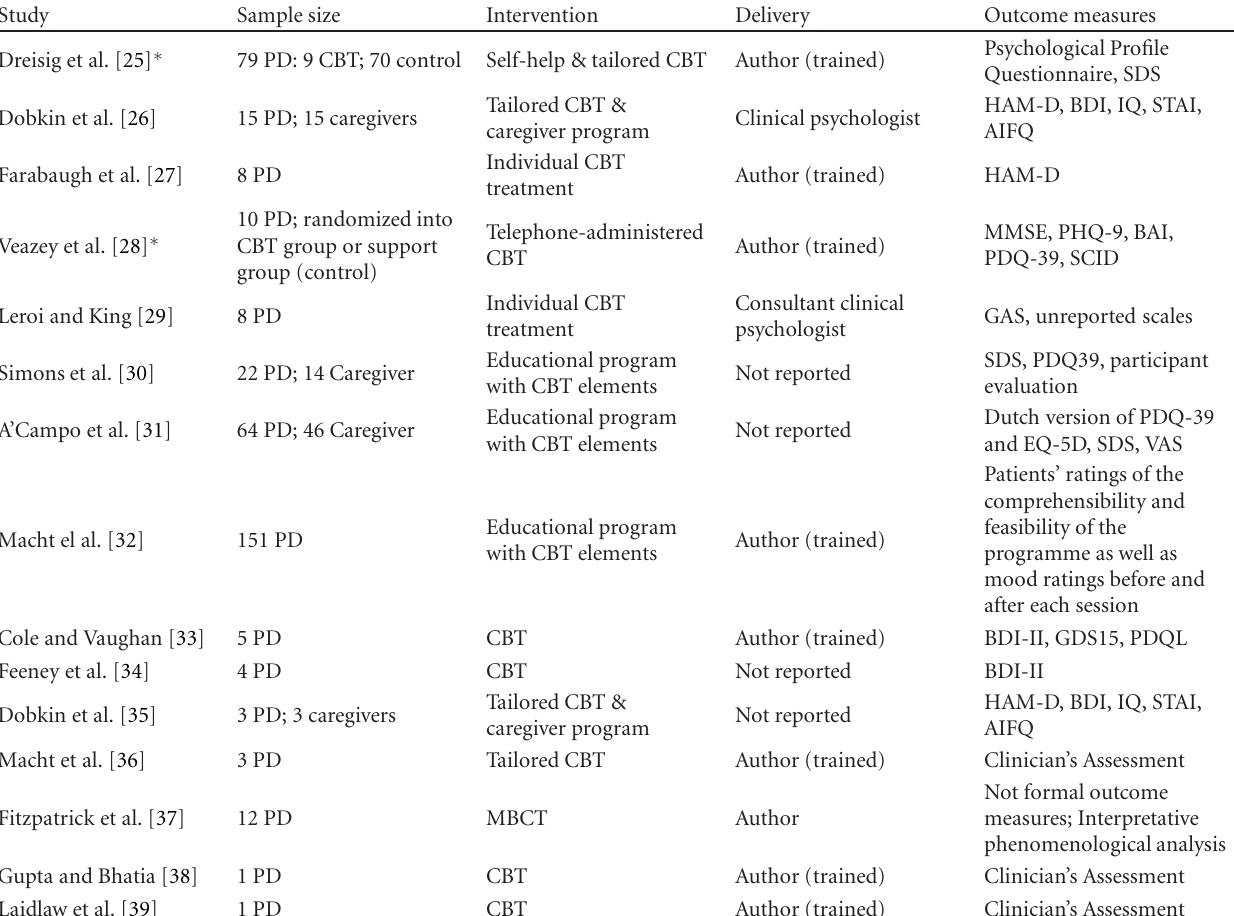
Table 1: Summary of studies reviewed focusing on CBT for patients with PD and